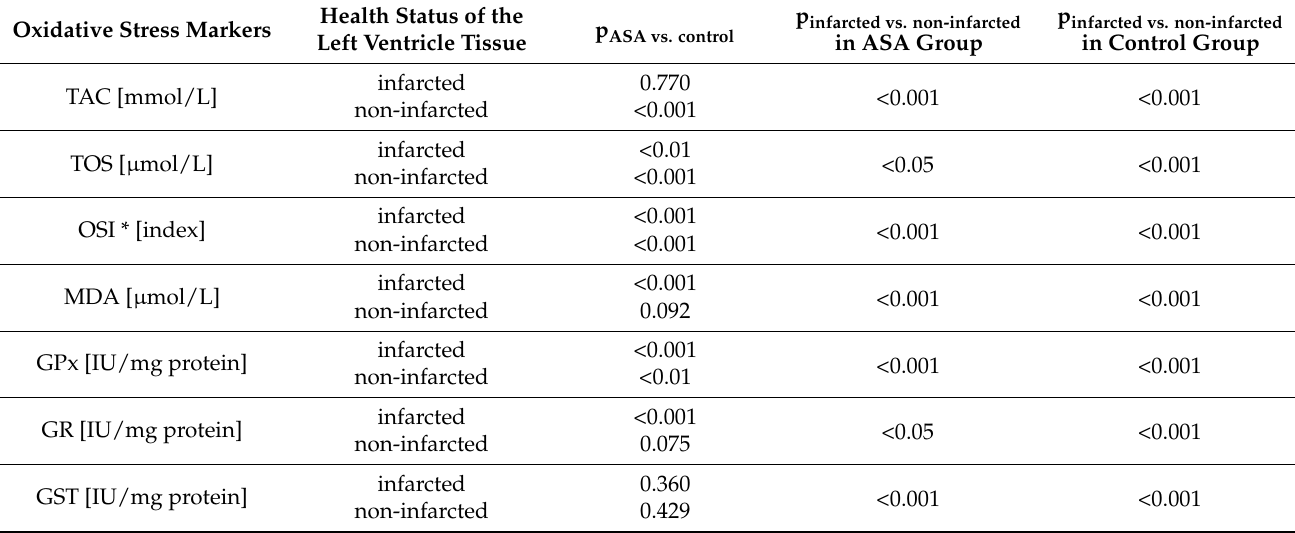
Table 3. Contrast analysis of oxidative stress markers in infarcted and the non-infarcted tis- sues collected from the left ventricle of the heart of pigs ( n = 13) subjected to a myocardial ischemia-reperfusion protocol assessing the effectiveness of intracoronary administered acetylsalicylic acid